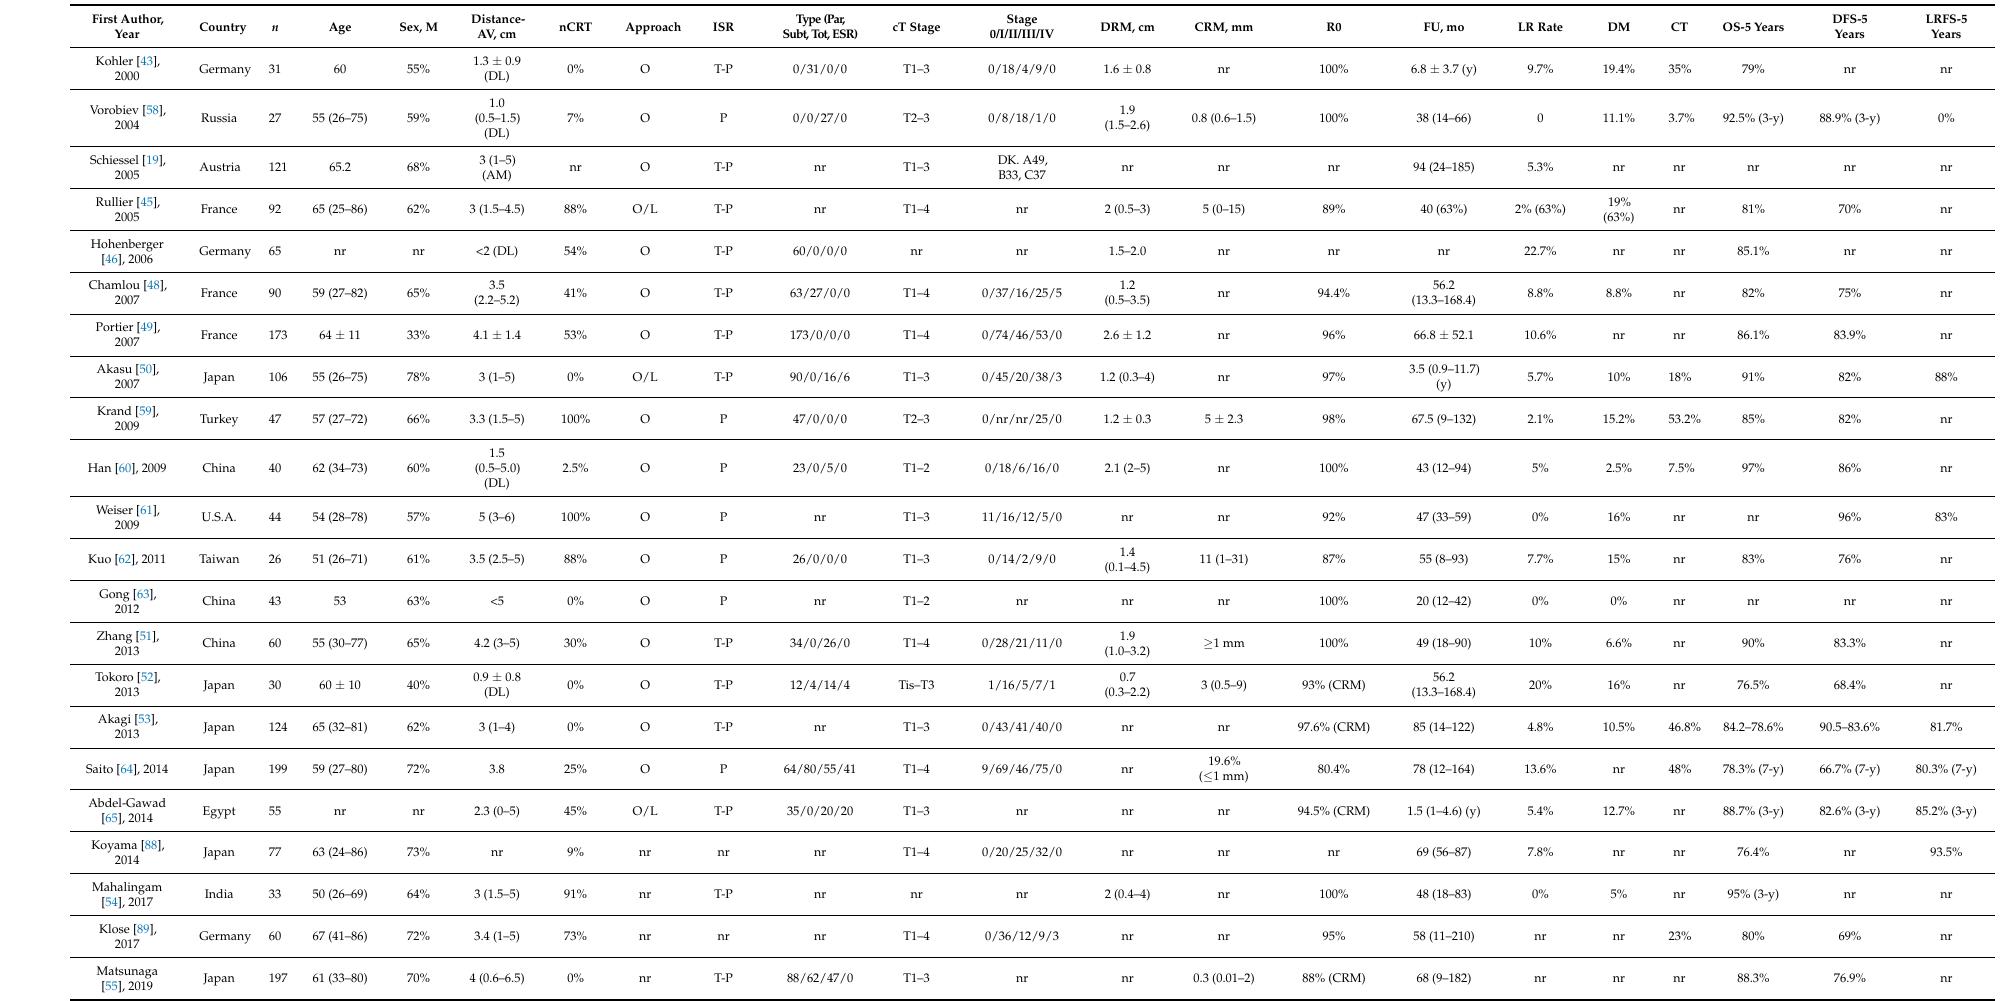
Table 2. Characteristics of patients and tumors from published series on